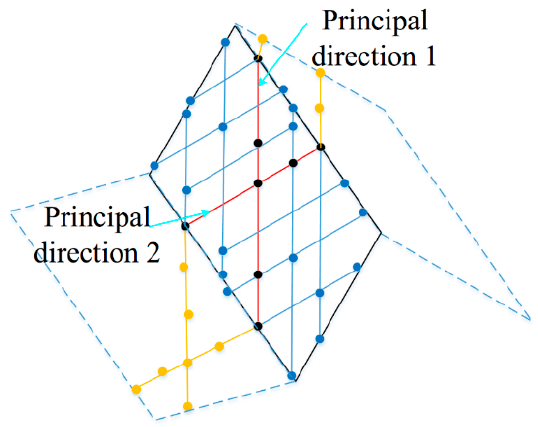
Figure 7. Step one of CLE growth.